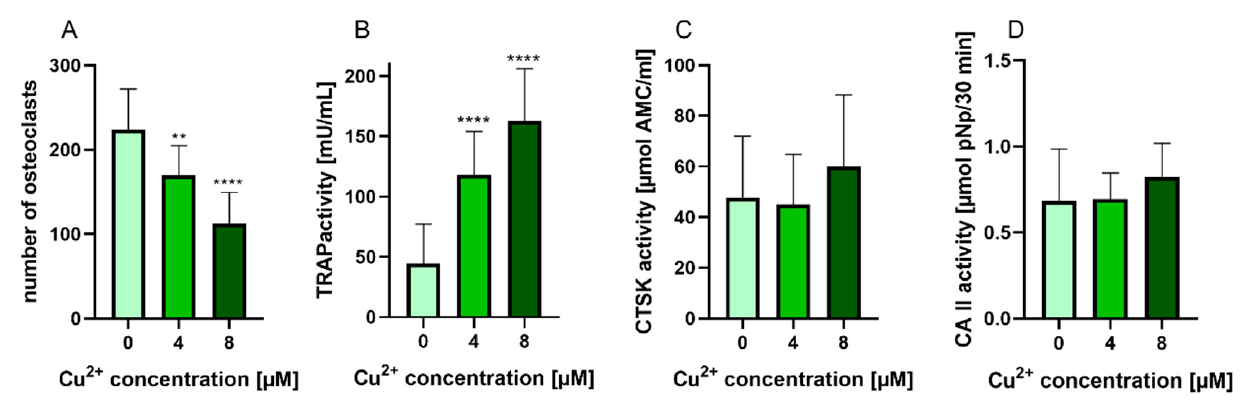
Figure 3. ( A ) Number of multinucleated TRAP positive osteoclasts differentiated from human PBMC after 14 days of cultivation, counted from light microscopic images (cells of two donors, xx images per condition) Statistic differences were calculated by one-way ANOVA, followed by Tukey’s test for multiple comparisons ( B ) TRAP activity, ( C ) CTSK activity and ( D ) CAII activity of osteoclasts differentiated from human PBMC after 14 days of cultivation. Data of 7 different donors (each n = 5) were included into the calculation. ( n = 35 in total). Statistical differences were calculated using Kruskal Wallis Test **** p < 0.0001.